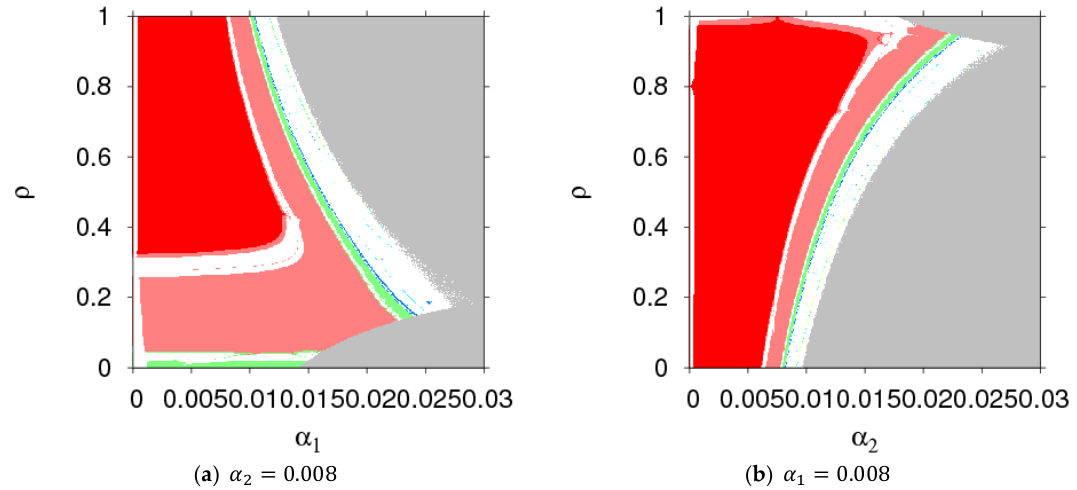
Figure 7. The evolution characteristics of dynamic System (7) when 𝜌 ∈ [0,1].